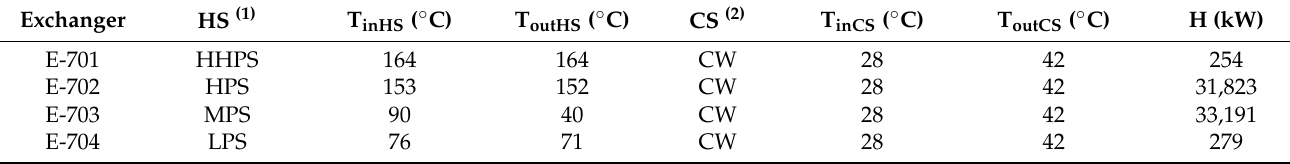
Table 10. Design of condensers for Unit 7.